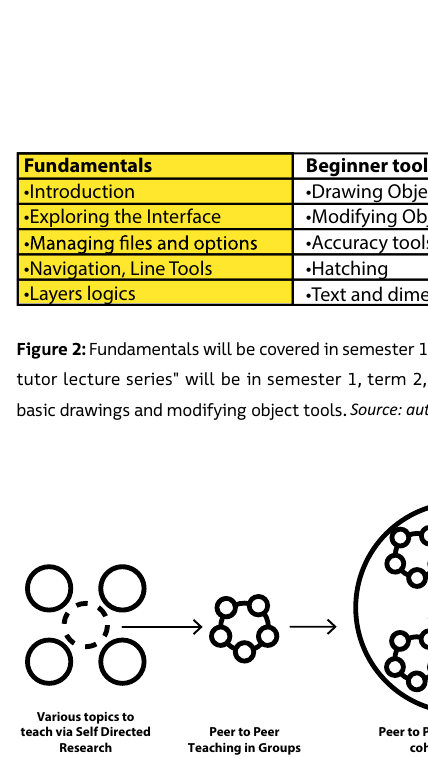
Figure 3: The "Peer Lecture Series" aims to bridge the gap and level-up students’ knowledge, to ensure a more equal footing between students at the later part of the academic year.